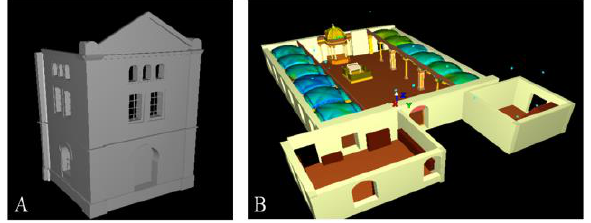
Figure 4. Fragment of the 3D model- synagogue building, A – part of the facade, B –